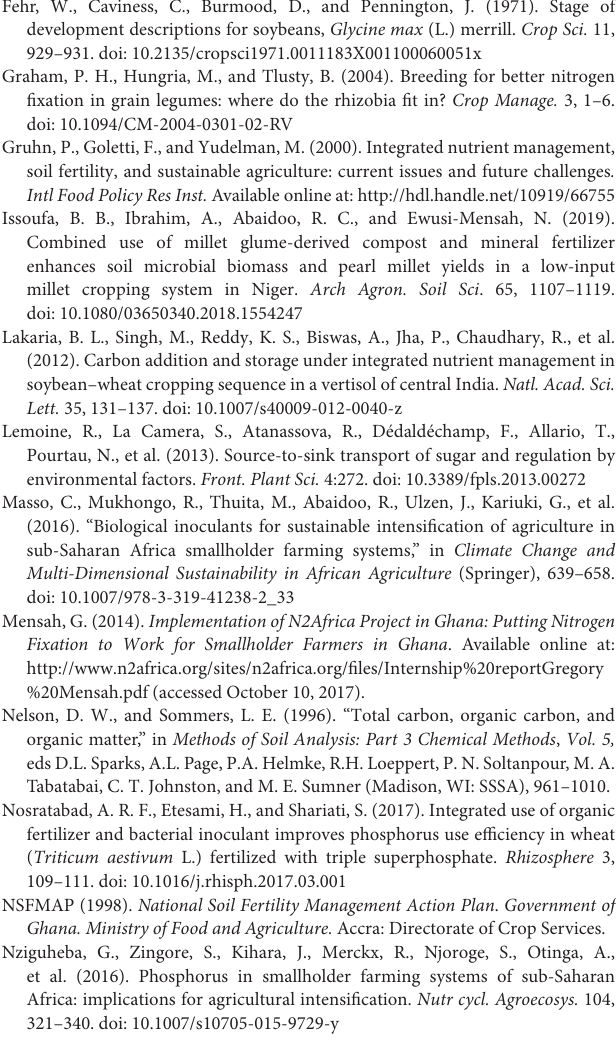
Figure S1 | Rainfall distribution pattern during the cropping season at Kpalga (A) and Tunayilli (B)